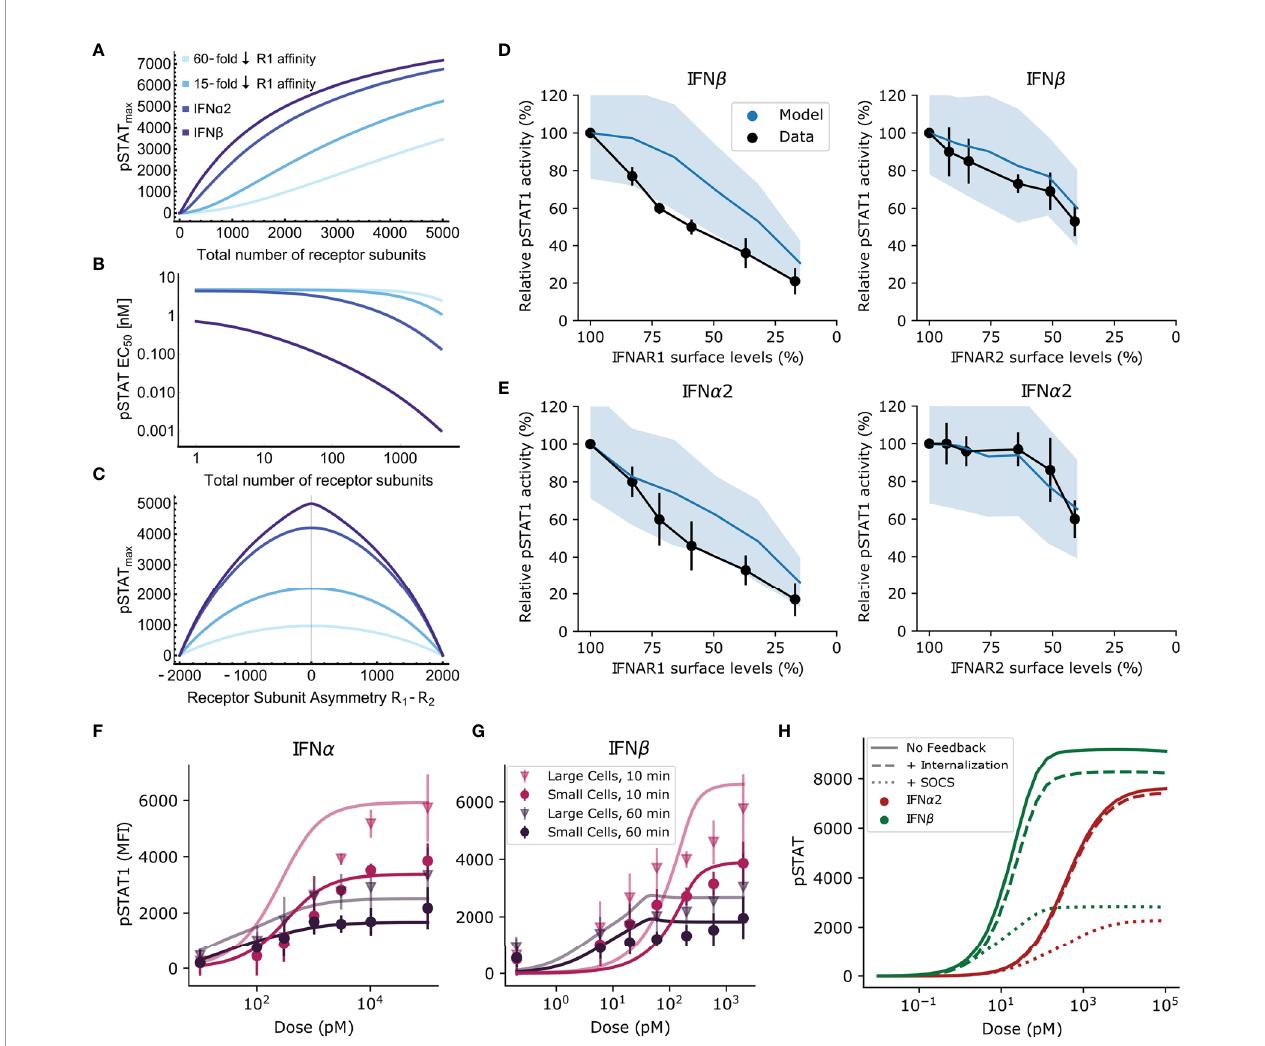
FIGURE 3 | Receptor expression levels can regulate signal speci fi city. (A, B) The equilibrium model predicts how pSTAT max (A) and pSTAT EC 50 (B) vary with the total number of receptor subunits on the cell surface. From violet to lightest blue, lines correspond to high af fi nity IFN b , lower af fi nity IFN a 2, and IFN a 2 mutants with 15-fold and 60-fold lower IFNAR1 af fi nity, respectively (see text). (C) The dependence of the response on the difference in expression of R1 and R2 subunits for each of the IFN subtypes from A&B. The results in (A – C) are similar for the computational model (not shown); see text. (D, E) pSTAT1 levels following siRNA transfection to knockdown IFNAR1 or IFNAR2 and subsequent stimulation for 45 minutes with 200 pM of IFN. Black: Western blot band intensity measurements; Blue: predicted response from model. Responses are normalized by maximum response. Model uses measured human IFN af fi nities and mean receptor density between 0.1 and